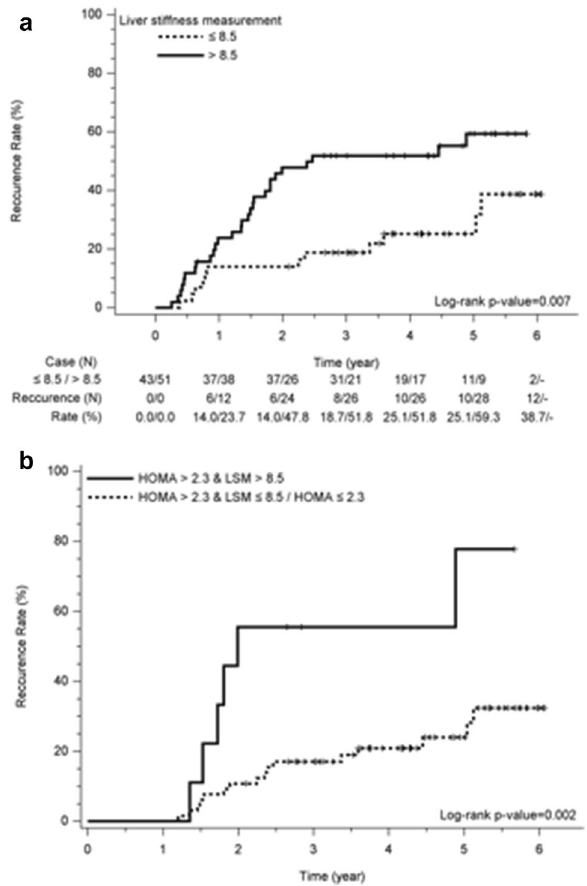
Figure 3. Stratified by 8.5 kPa in liver stiffness (LS) and 2.3 in homeostatic model assessment for insulin resistance index (HOMA), a. those patients with LS > 8.5 kPa had a significantly higher recurrence rate and b. those patients with both LS > 8.5 kPa and HOMA > 2.3 had the highest recurrence rate after 1-year post